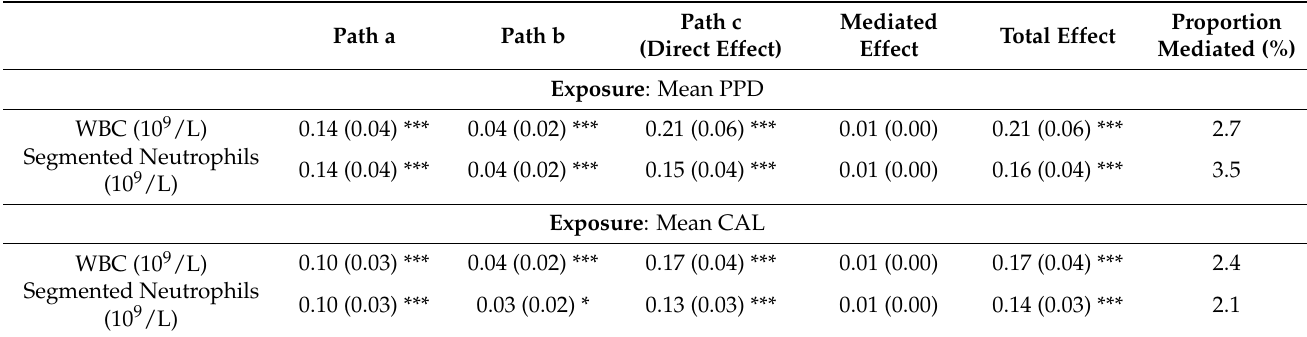
All models were conducted adjusted for sociodemographic variables (age, gender, race, education), health behaviors (minutes of seden- tarism, smoking habit, alcohol use), body mass index, number of missing teeth and systemic status (number of medical conditions, systolic